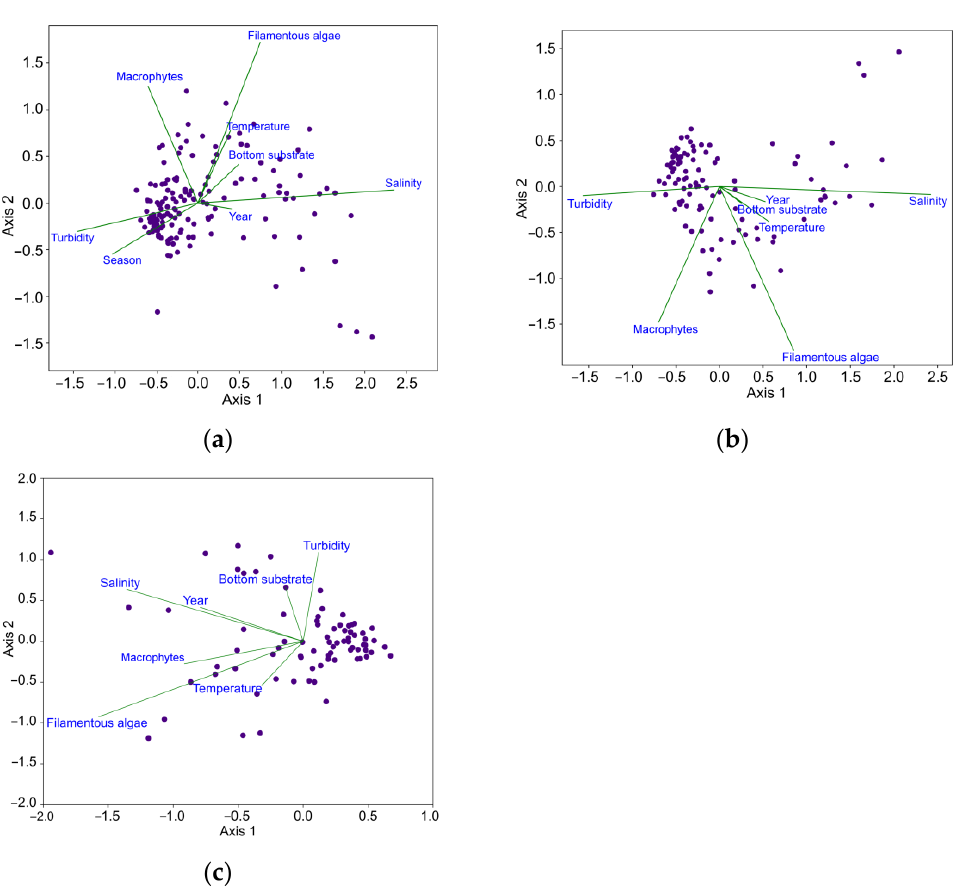
Figure 2. The results of CCA using data on the abundance of species at sampling locations in combination with the values of environmental and seasonal variables. ( a ) The seasonal factor is included in the analysis. ( b ) The seasonal factor is excluded from the analysis (samples of only summer period included). ( c ) Samples of summer period within area with salinity 0.0 –1.9‰.